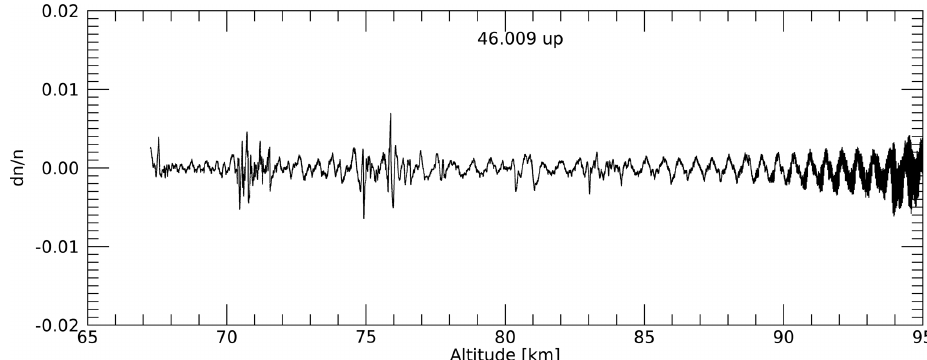
Figure 5. Example of CONE relative density fluctuations for flight 46.009 upleg.